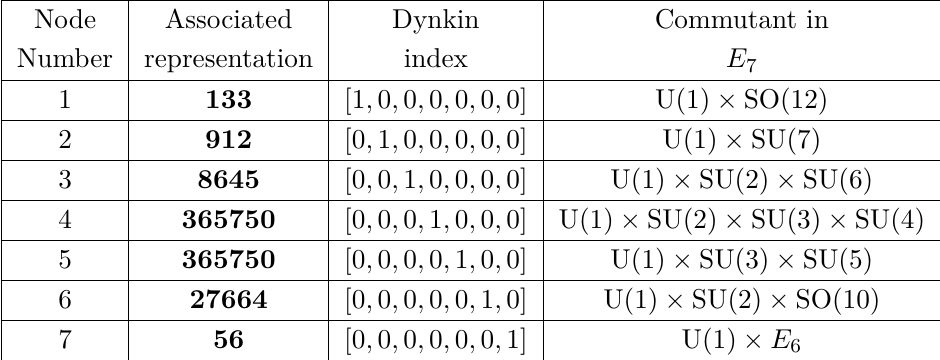
Table 1 . Representations associated with each node of the E 7 Dynkin diagram and the subgroup that they